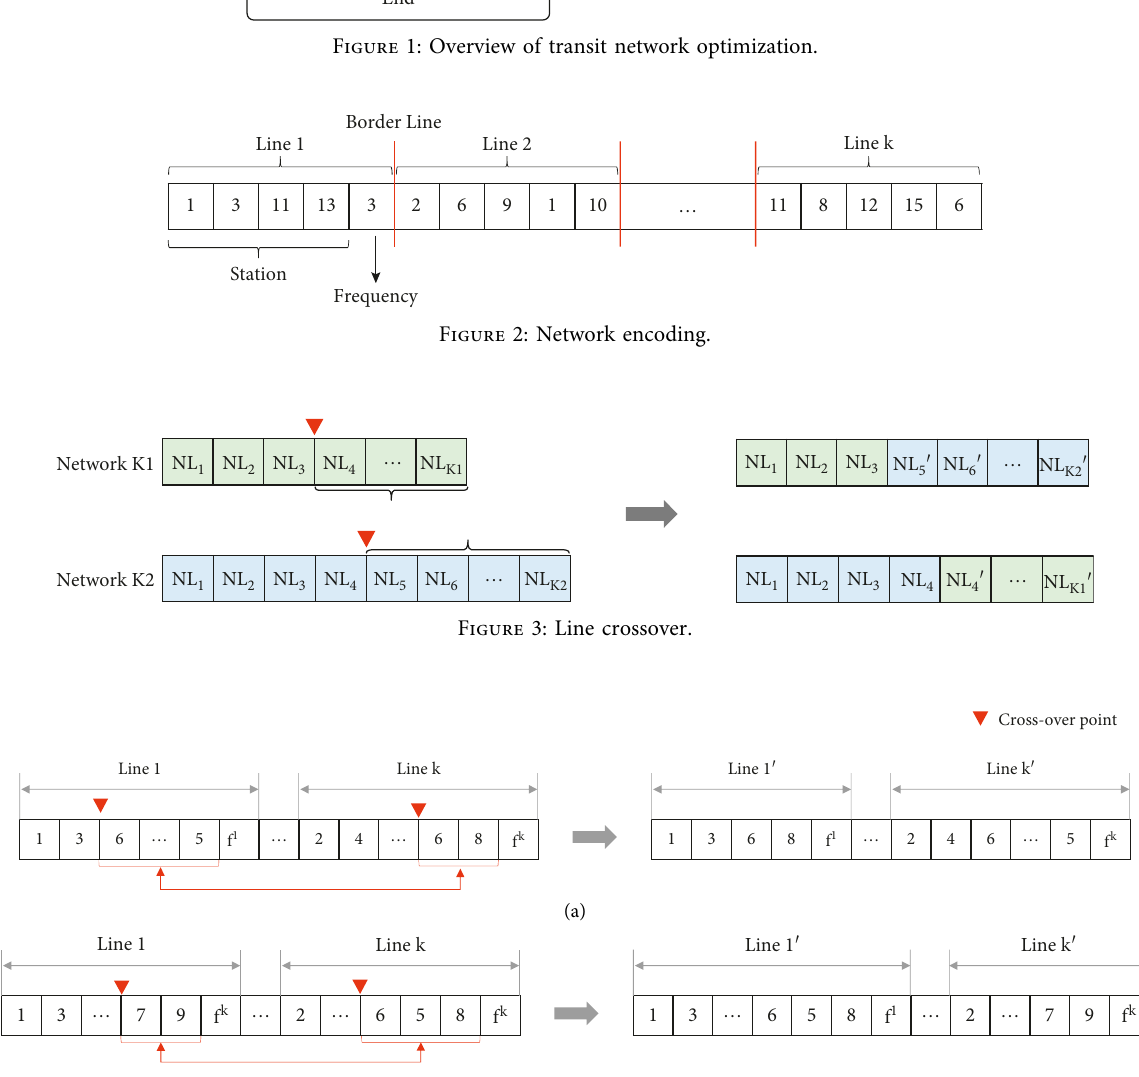
Figure 2: Network